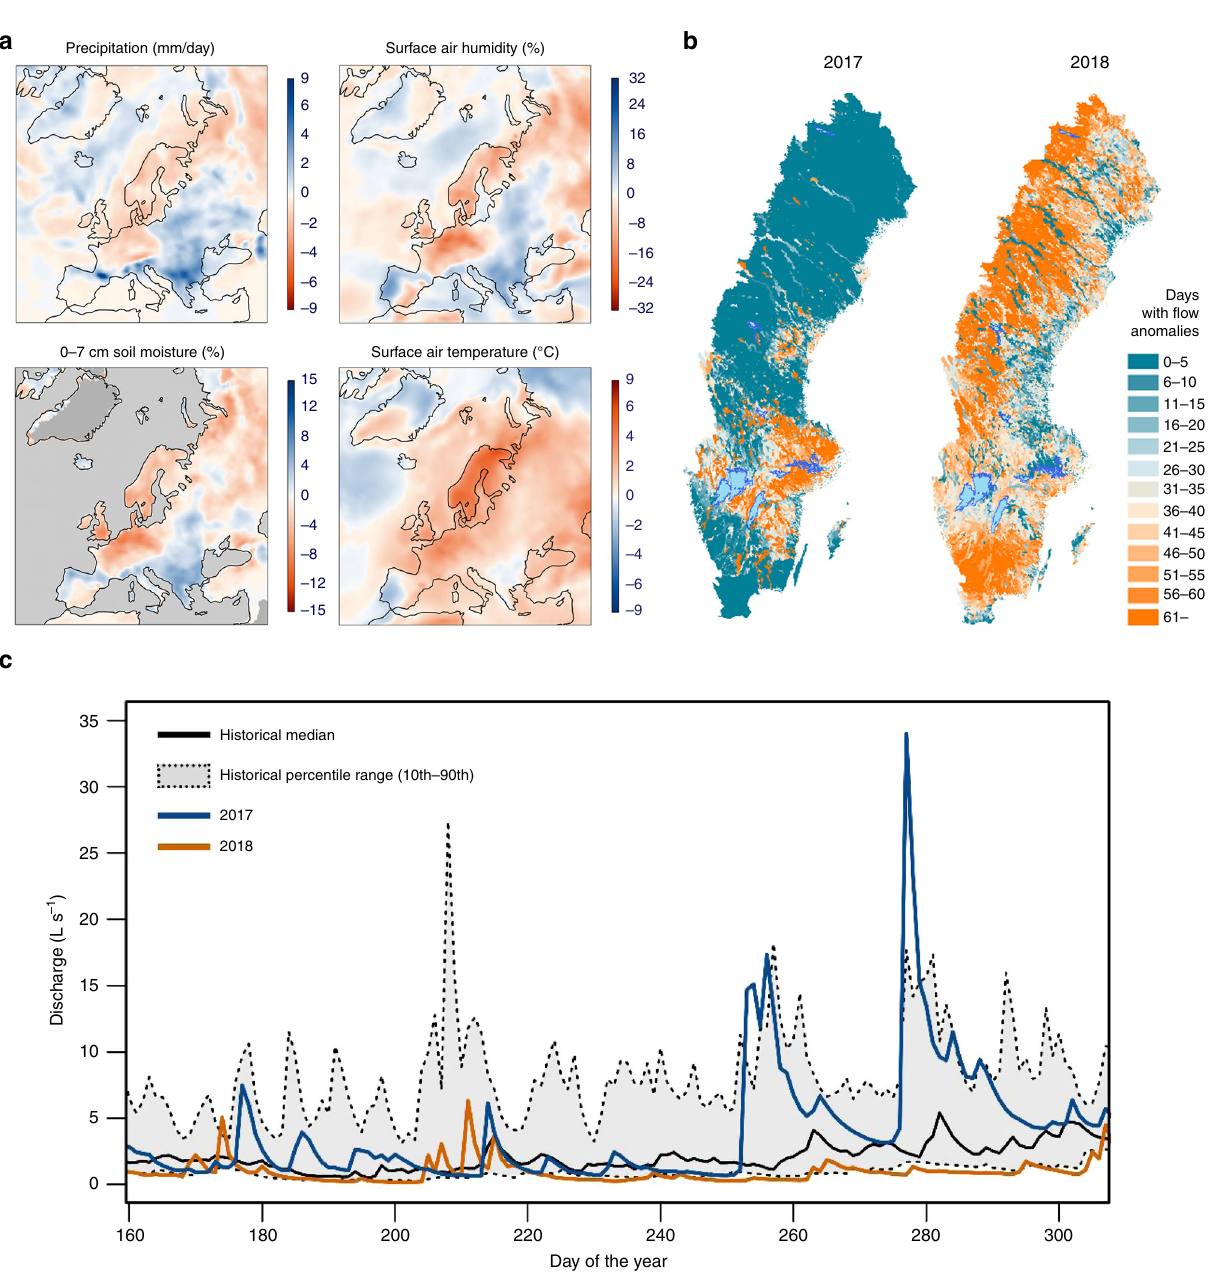
Fig. 1 The summer 2018 drought in northern Europe. a Spatial distribution of July 2018 anomalies of the primary factors controlling the water balance of watersheds over Europe (average deviation for July 2018 relative to the monthly average for the period 1979 – 2018; Source: European Centre for Medium- Range Weather Forecasts (ECMWF), Copernicus Climate Change Service (C3S)). b Comparison of the spatial distribution of summer fl ow anomalies for 2017 and 2018 over Sweden (daily fl ow deviation for summer 2017 and 2018 relative to the daily summer fl ows for the period 1963 – 1992; Source: Swedish Meteorological and Hydrological Institute (SMHI)). c Summer 2018 stream fl ow anomaly for a headwater stream in the KCS. The fi gure shows the median daily discharge and the daily 10th to 90th percentile values during summer between 1985 and 2018 (black solid line and gray shade, respectively). Daily discharge for 2017 and 2018 periods is shown in blue and orange solid lines,